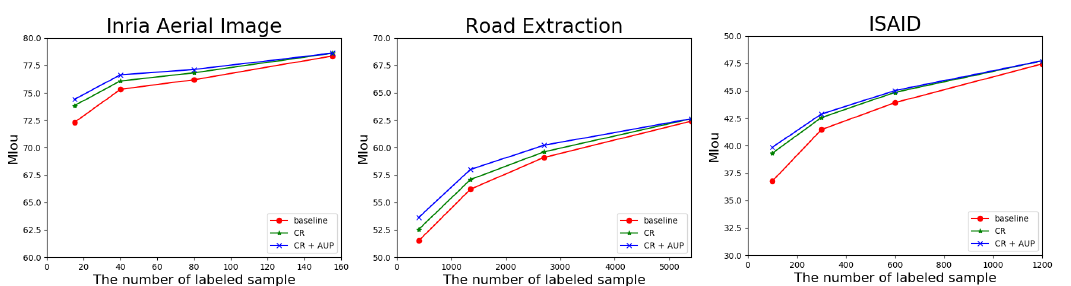
Figure 7. Variation of segmentation performance of the proposed CR and AUP method with different numbers of labeled training samples on three